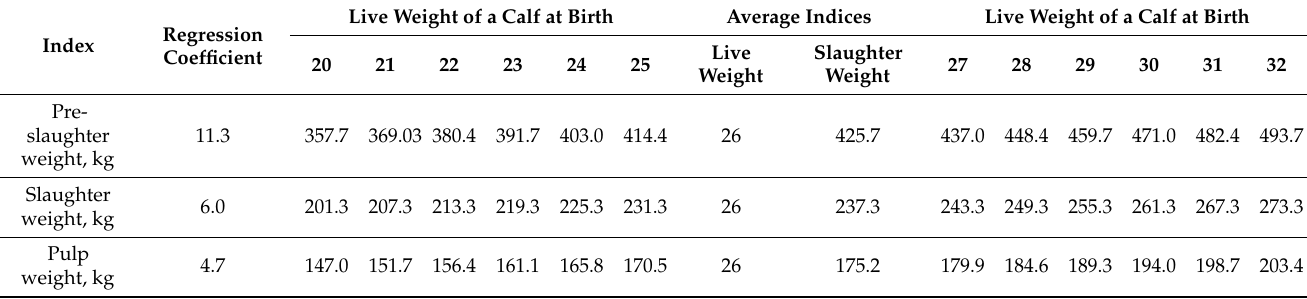
Table 4. Table for predicting the meat productivity of animals by their live weight at birth.